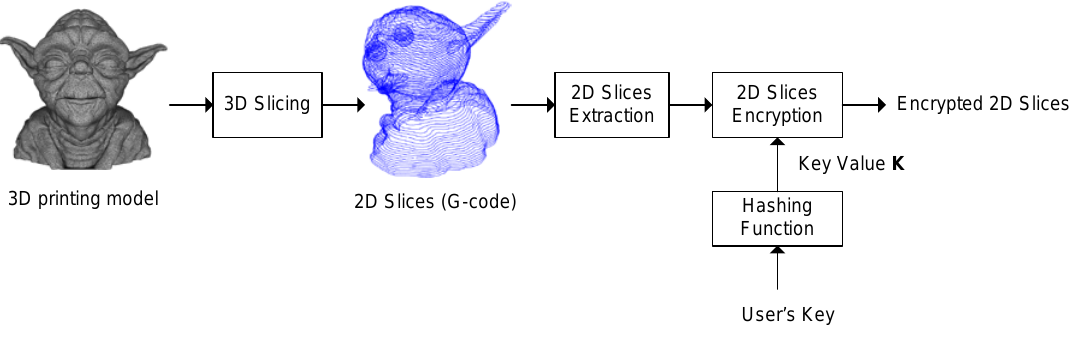
Figure 5. The proposed solution.